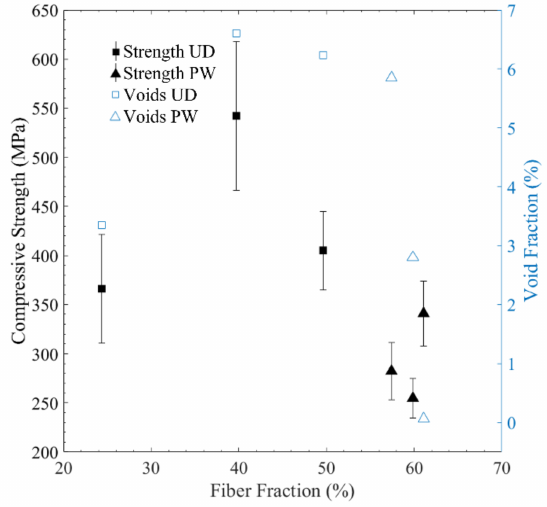
Figure 2. Compressive strengths of manufactured PT 30 composites with UD and PW fibers at room temperature.